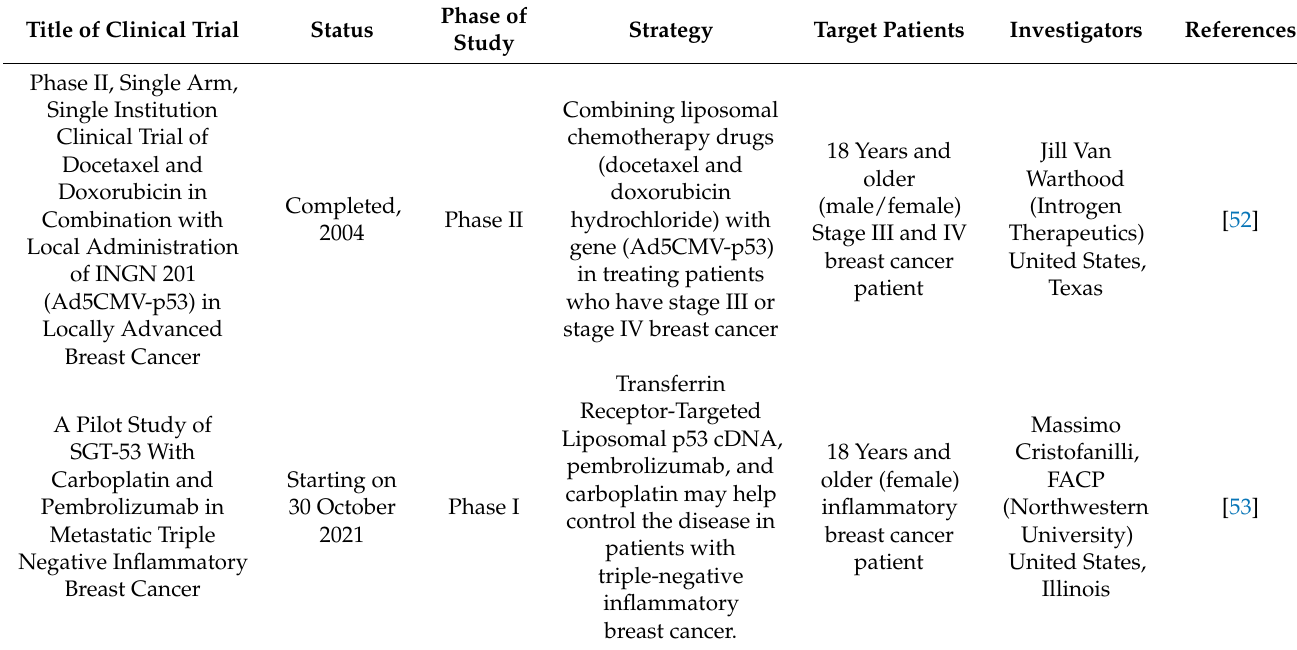
Table 4. Clinical studies of liposome-based breast cancer gene therapy (data obtained from www. clinicaltrials.gov (accessed on 7 July